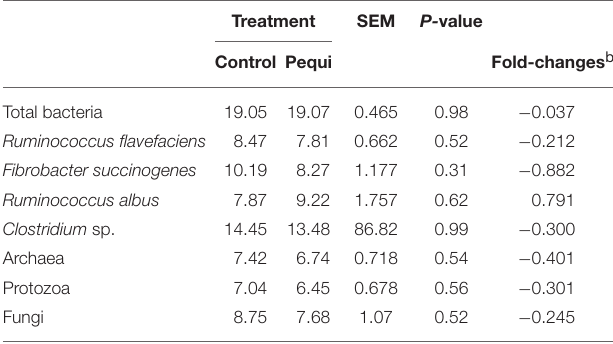
TABLE 8 | Effect of pequi oil on rumen microbial diversity a in wethers fed a hay-based diet fold-changes for specific groups after supplementation of pequi oil.